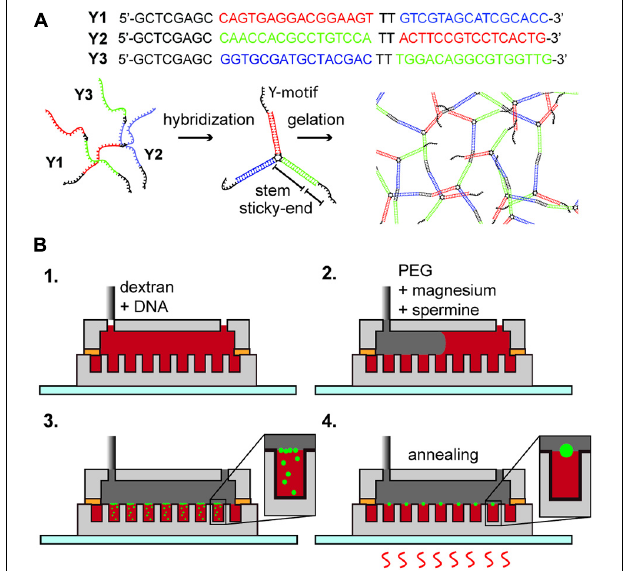
FIGURE 1 | (A) DNA hydrogel; DNA Y1, Y2, and Y3 hybridize into a motif which forms a network structure by the hybridization of the sticky-end portion. (B) Formation of DNA hydrogel inside an aqueous two-phase system droplet array. (1) Insertion of dextran with Y1, Y2, and Y3 oligonucleotides. (2) Insertion of PEG containing magnesium ions and spermine. (3) Diffusion of magnesium ions and spermine into the dextran droplets, forming DNA aggregates at the interface. (4) Multiple thermal annealing of the device and generation of an aqueous triple-phase system DNA/dextran/PEG.